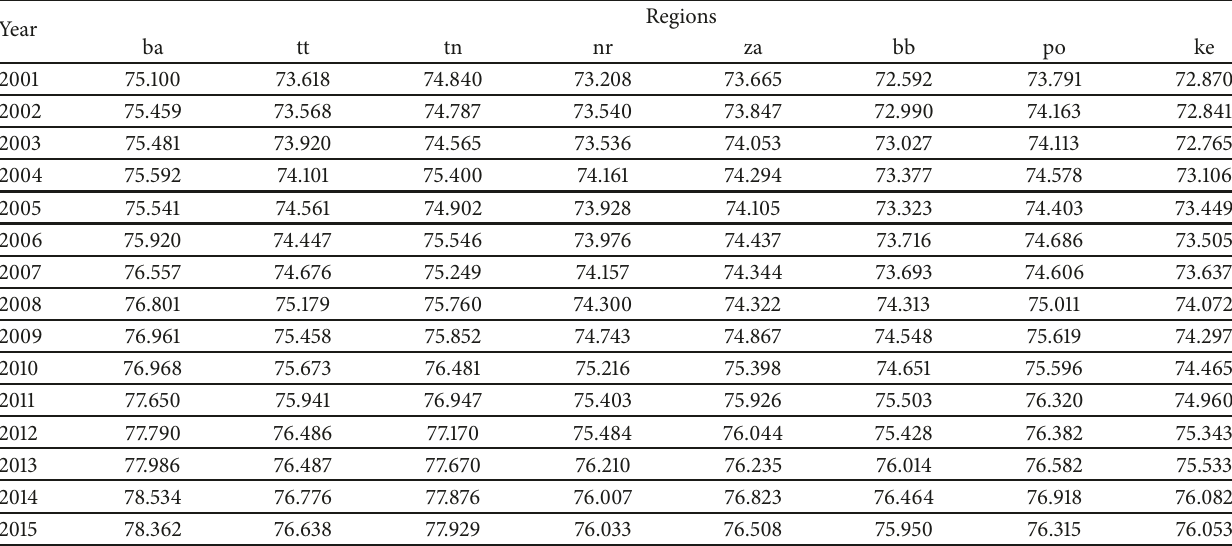
Table 1: Life expectancy (in years) at birth (age 0) for Slovak regions.